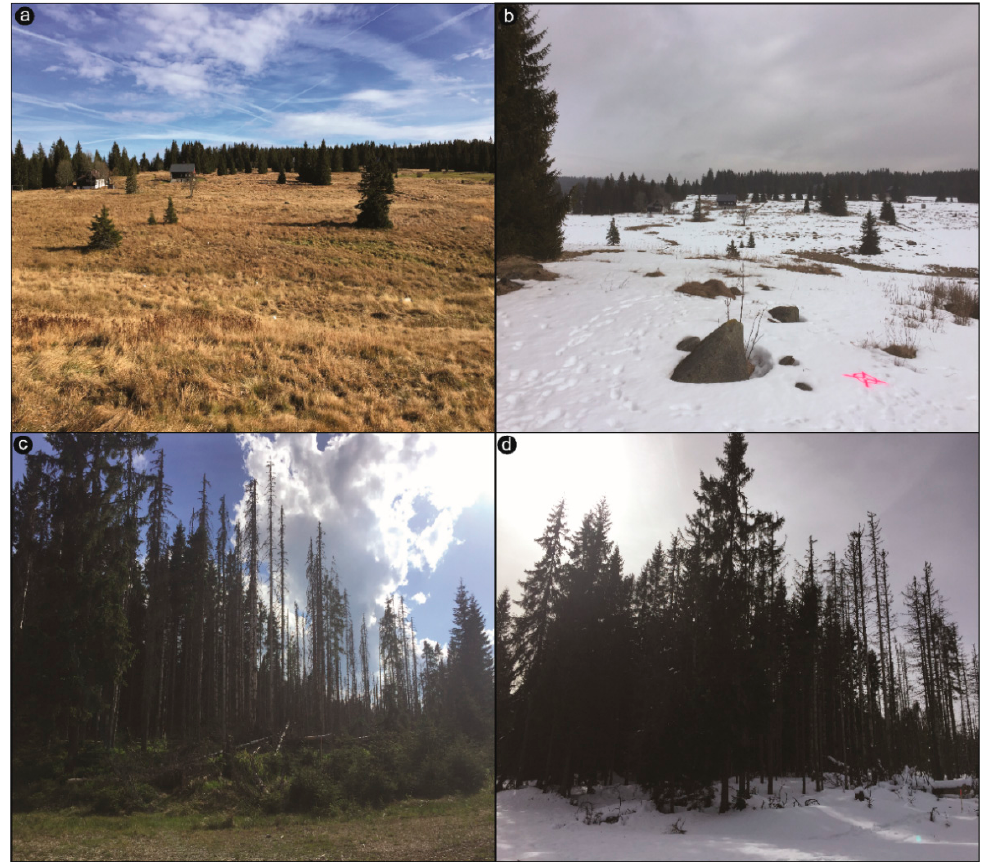
Figure 12. ( a , b ) Photographs of the meadow coverage with up to 0.40 m high grass and partly scattered rocks during summer and wintertime at the open area; ( c , d ) Dead wood lying on the ground during the snow-free period and at the base of the snow-cover.